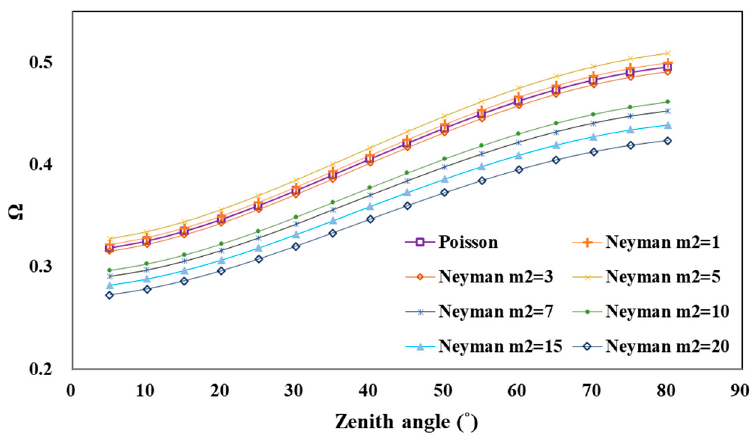
Figure 17. Clumping index variation with zenith angle for different tree trunk heights. Simulation parameters as shown in Table 2, column 5.